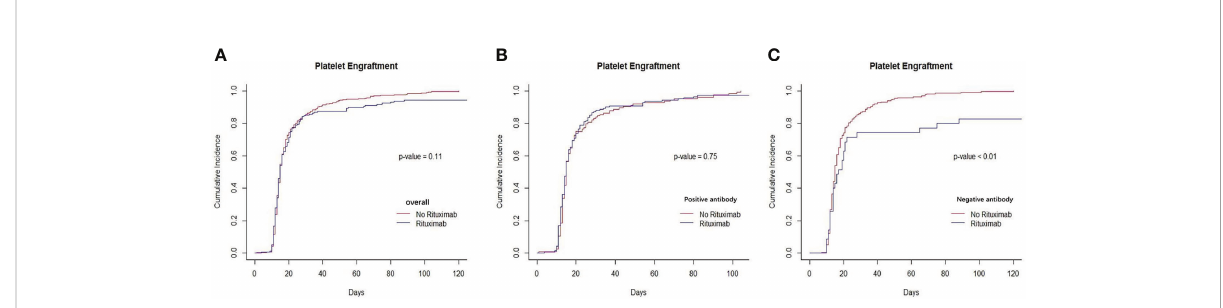
FIGURE 2 Recovery of platelets between rituximab and non-rituximab groups. (A) The cumulative incidence of platelets engraftment in entire patient cohort. There was no difference in the cumulative incidence of platelets engraftment rituximab and non- rituximab groups in entire patient cohort (P= 0.11). (B) The cumulative incidence of platelet engraftment in positive anti-HLA antibody group. There was no difference in the cumulative incidence of neutrophil engraftment between 2 groups in positive antibody group (P= 0.75). (C) The cumulative incidence of platelet engraftment in patients with negative anti-HLA antibody group. There was signi fi cantly between 2 groups in the cumulative incidence of platelet engraftment in patients with negative anti- HLA antibody